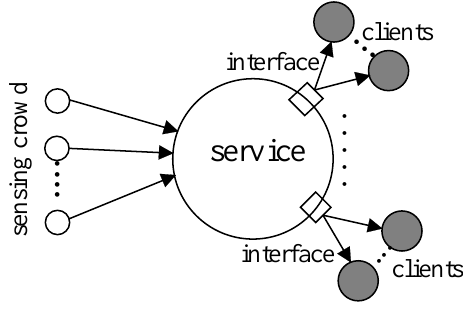
Figure 4. Crowd-Sourced